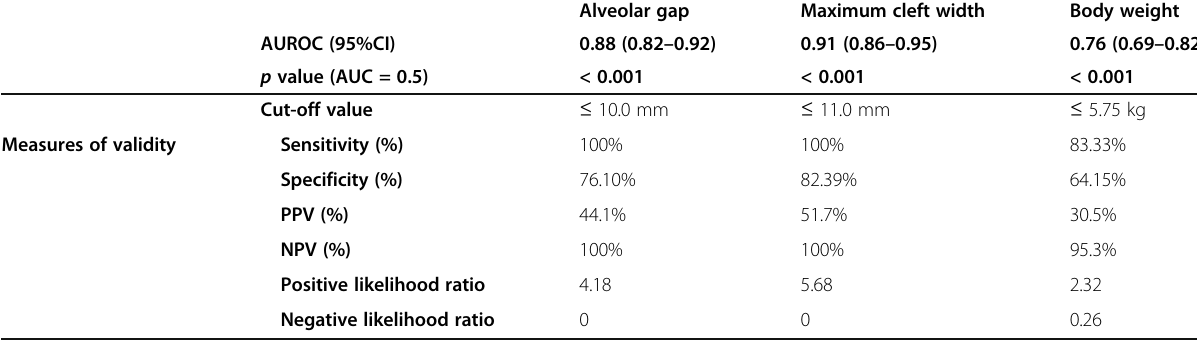
Table 3 ROC analysis for the validity of alveolar gap, maximum cleft width, and body weight in prediction of difficulty of